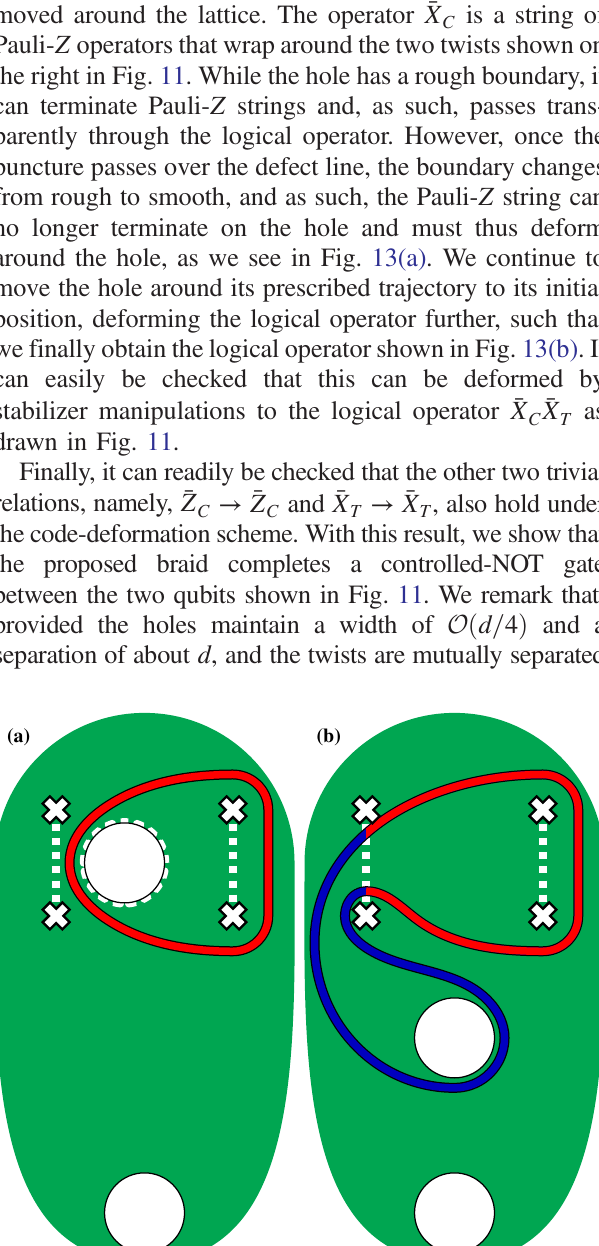
FIG. 13. The transformation deformation scheme. Diagram (a) shows how around the hole when the hole lies in between the four twists. (b) Once the hole has been deformed around the two lower twists of the lattice and is returned to its initial position, the logical ¯ X operator C is deformed onto a string operator that is equivalent up to stabilizer multiplication to the logical operator show in Fig.